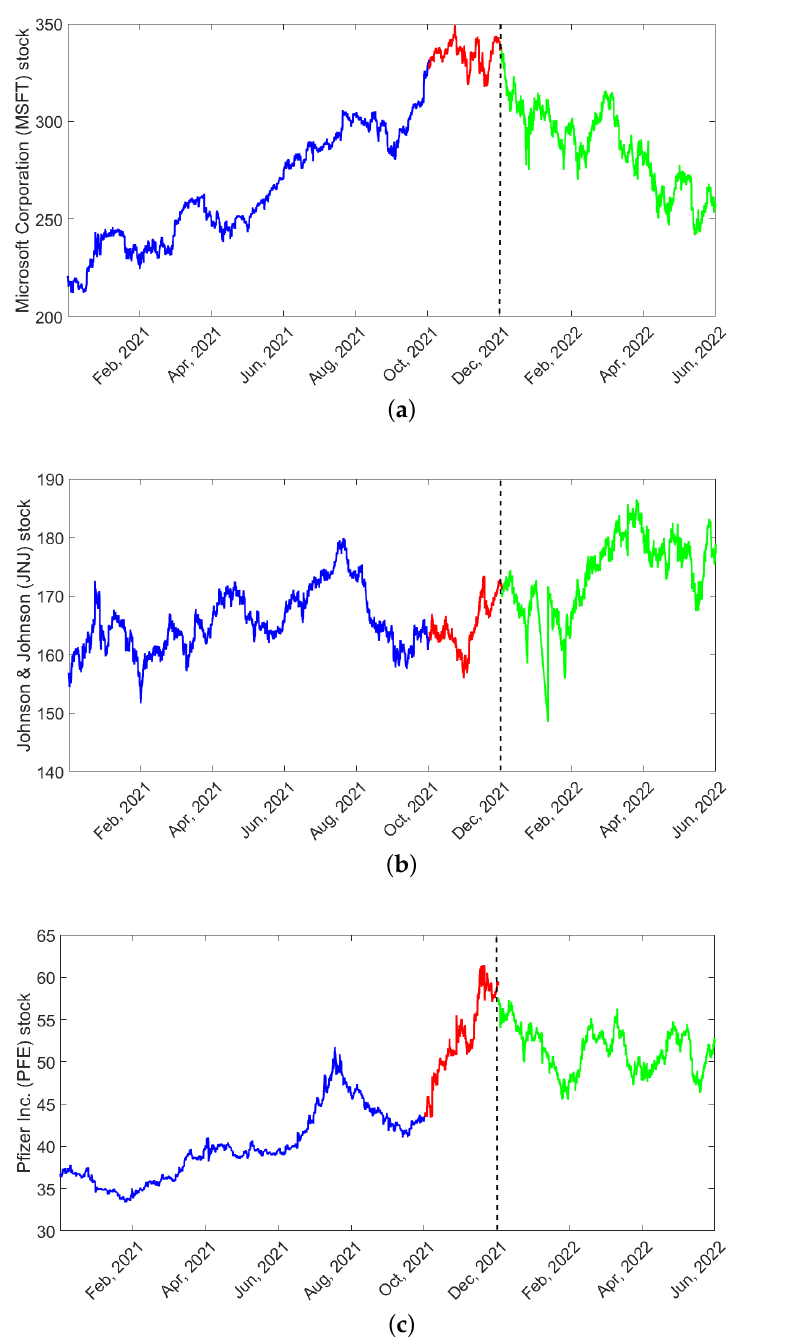
Figure 7. Timeseries plots of MSFT, JNJ and PFE stocks. ( a ) Microsoft Corporation. ( b ) Johnson & Johnson. ( c ) Pfizer